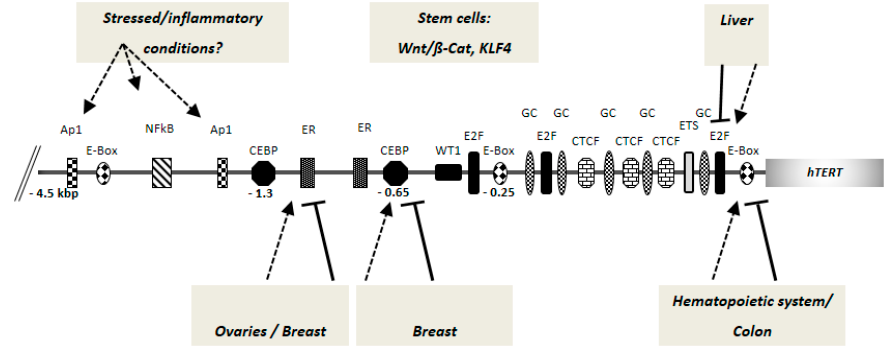
Figure 1. Putative and bona fide cis -regulatory elements of human telomerase reverse transcriptase ( hTERT ) gene promoter. Current research indicates that different factors can act in a tissue specific manner for hTERT/telomerase regulation. A 4.5 kbp hTERT promoter fragment upstream of the AUG start codon is shown (not drawn to scale). The numbers denote the distance from the AUG start site. The arrows indicate activation and the lines indicate repression of hTERT promoter by the same binding site, depending on the occupation by the respective tissue-specific regulatory factors (see text for details). The mode of action by the stem cell specific factors is not fully clear. E-box: c-Myc/Mad-family factor binding sites; E2F: E2 factor family transcription factor binding sites; GC: GC-box binding sites; ETS: ETS-domain binding sites; CTCF: CTCF factor binding sites; CEBP: CEBP family factor binding sites; ER: estrogen receptor binding sites; Ap1: Ap1 factor binding sites; NF κ B: NF κ B factor binding site; WT1: binding site for the Wilms’ tumor 1 transcription